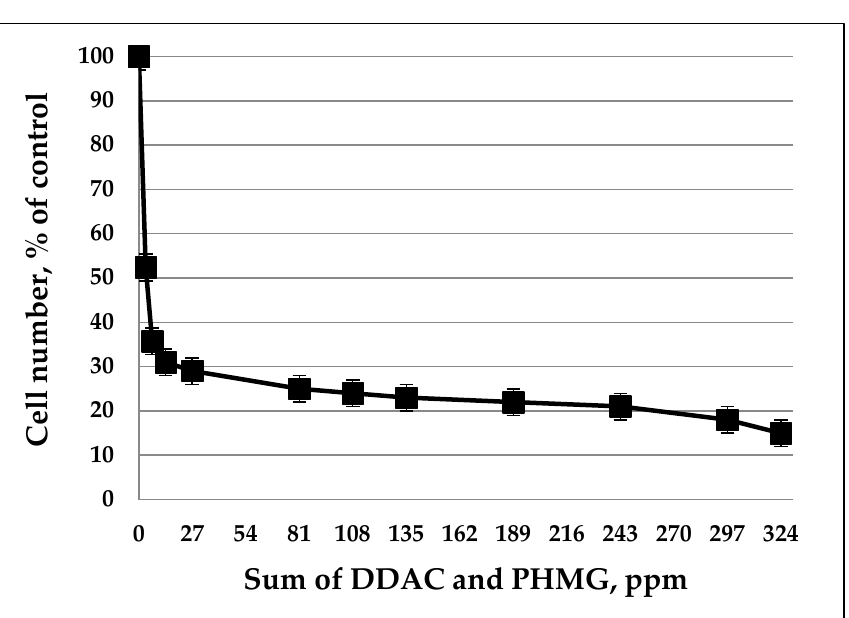
Table 4. MIC and MBC of some individual GACs and guanidine and biguanide derivatives for A. faecalis DOS7 in comparison to biocide “Latrina”.